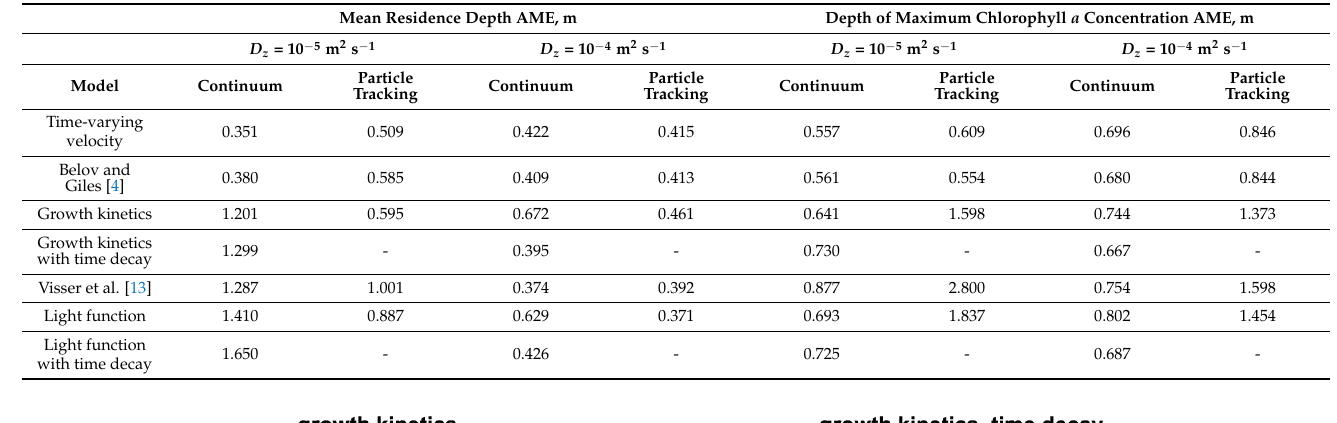
Table 6. Error statistics for models of Xiangxi Bay.